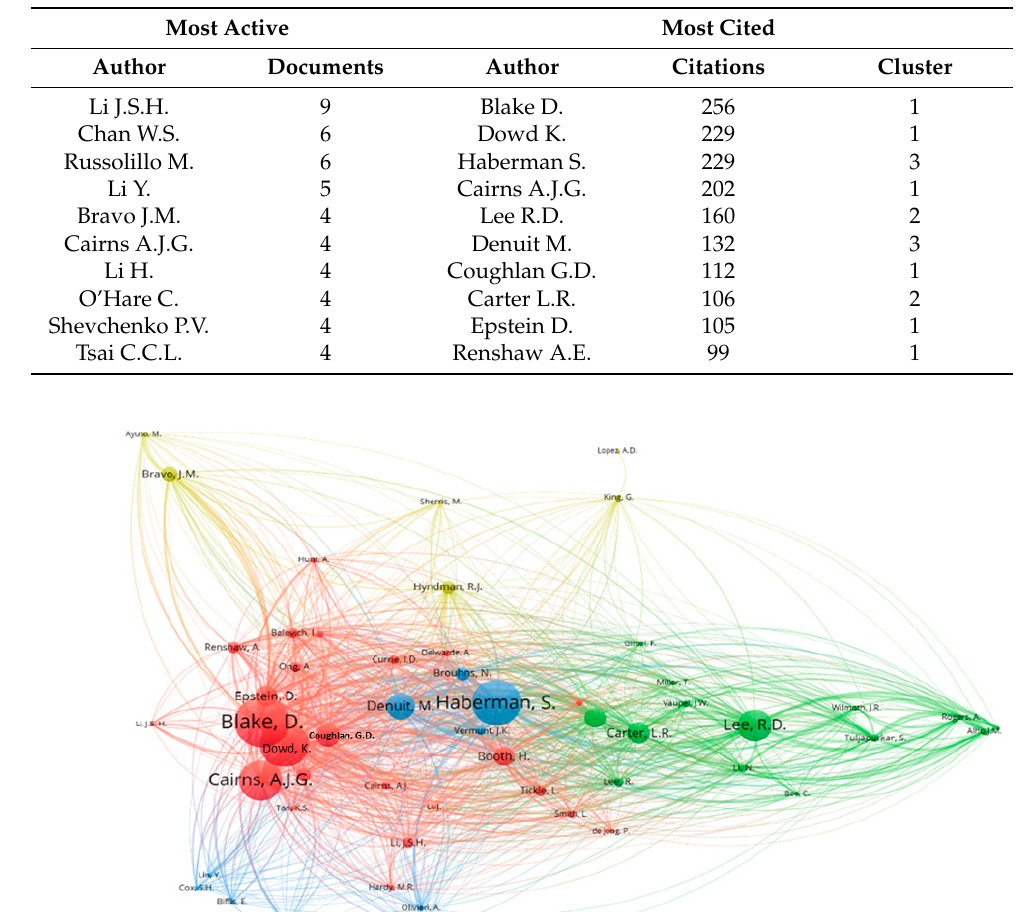
Table 3. Top 10 most active sources.